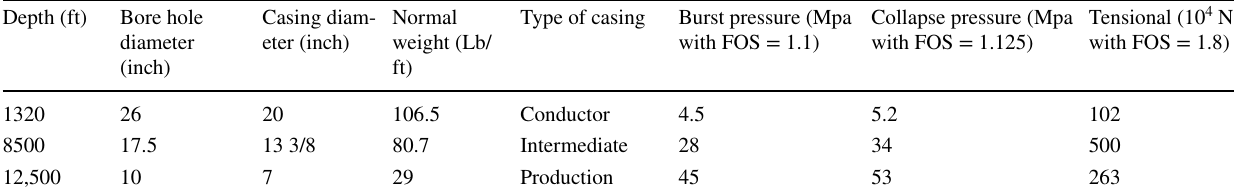
Table 4 Calculated designed requirement for the casing pipes Depth (ft)